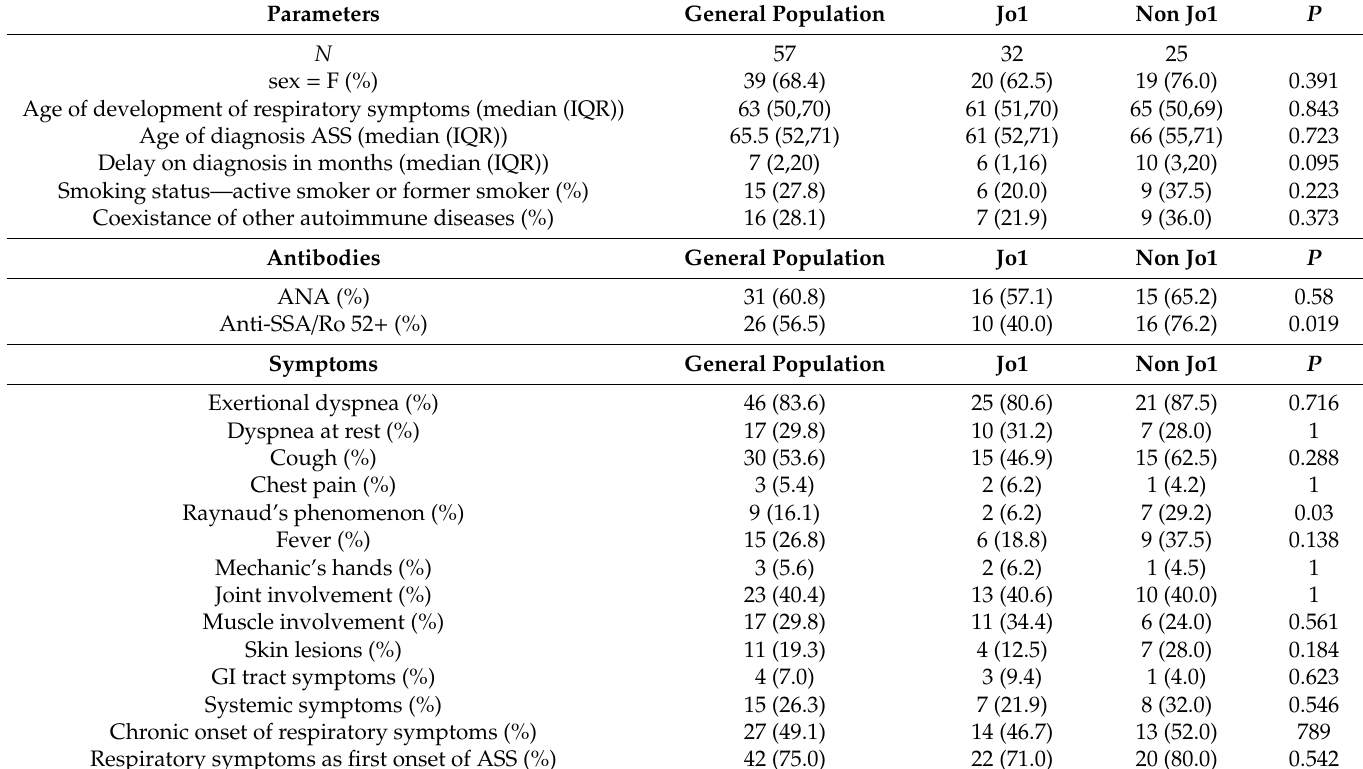
Table 1. Demographic, clinical, serological features, and lung function parameters at